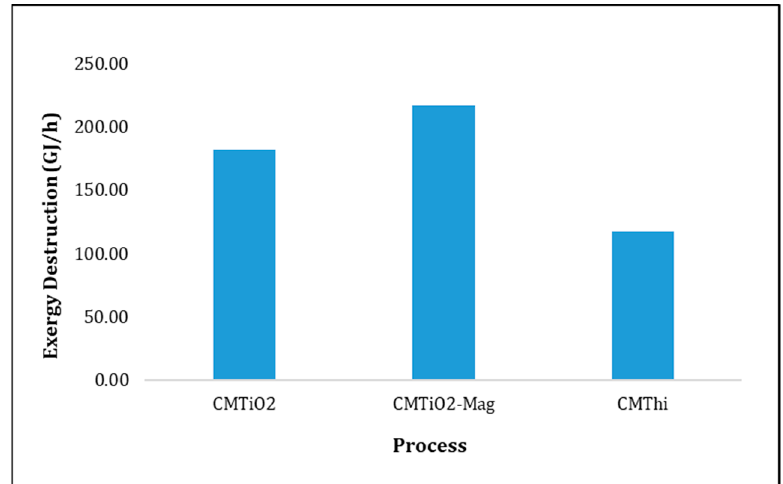
Figure 7. Comparison of exergy destruction for each processing route.